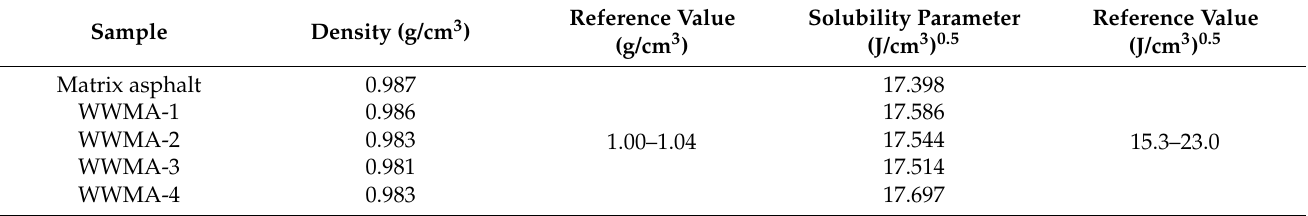
Table 6. Density of matrix asphalt and